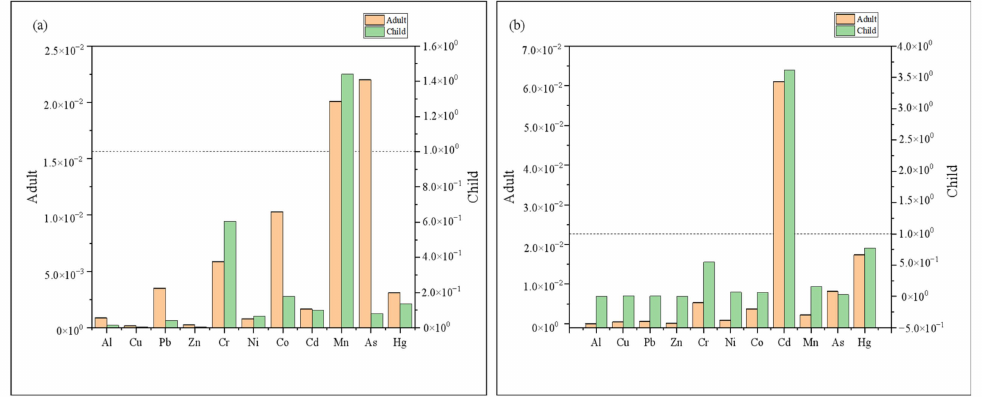
Figure 7. HI for adults and children during the wet ( a ) and dry ( b ) seasons.